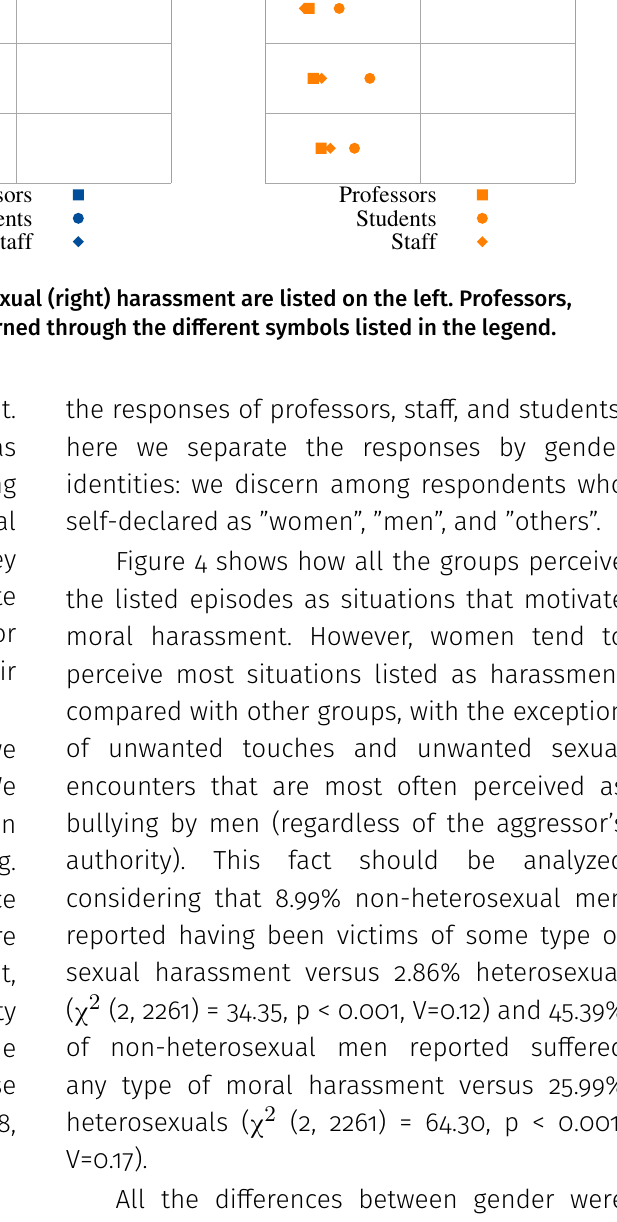
creates more obstacles for the